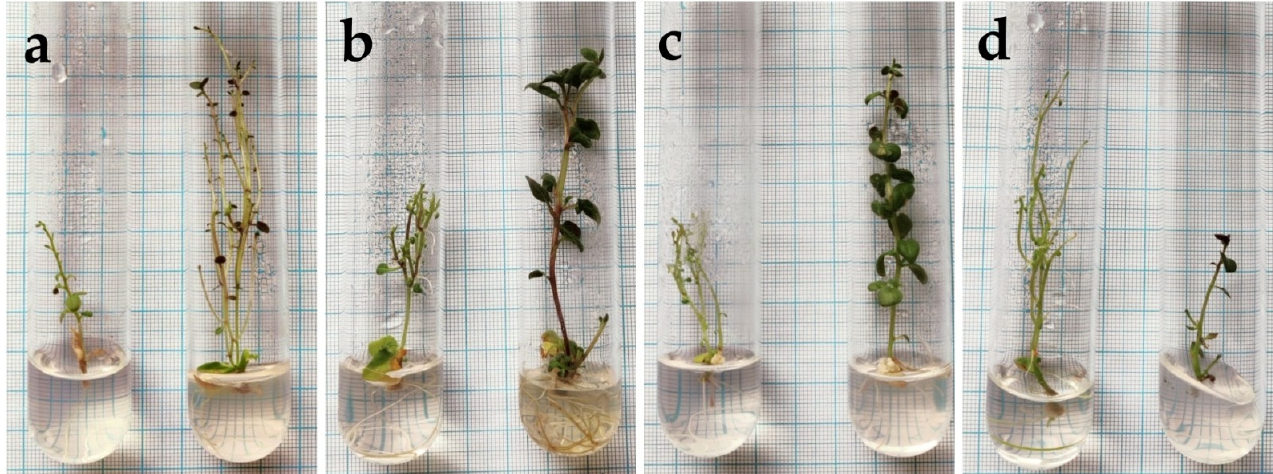
Figure 2. Subculture of micro-cuttings for each studied PFP variety after three weeks from the initiation moment; MS medium—left side; MS + Gly medium—right side; ( a ) Blue Danube; ( b ) Salad Blue; ( c ) Violet Negretin; ( d ) Violet Queen. Table 8. Morphometry of plantlets after the third subcultivation on MS and MS + Gly culture media. Shoot Length Variety